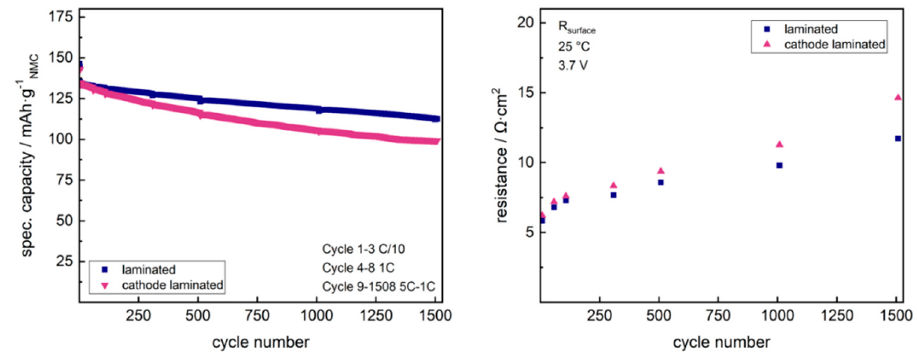
Figure 8. Decrease of discharge capacity vs. increase of surface resistance of laminated and cathode-laminated single cells along fast-charging cycles.